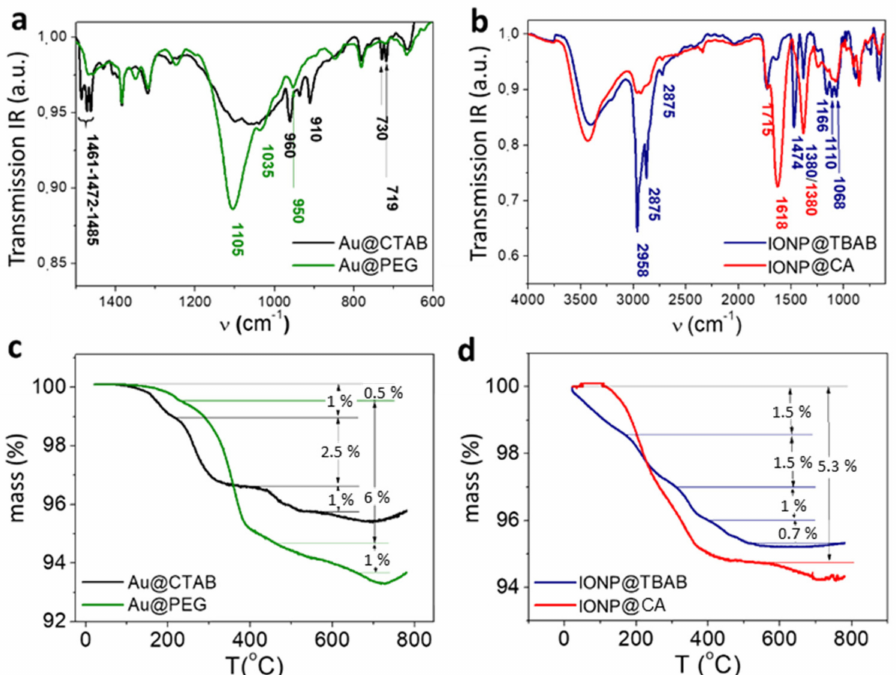
Figure 2. ( a ) FT-IR transmission spectra and ( c ) TGA curves of the AuNR coated with CTAB (Au@CTAB), and the AuNR after PEG functionalization (Au@PEG). ( b ) FT-IR transmission spectra and ( d ) TGA curves of IONP coated with TBAB (IONP@TBAB), and again after treatment with CA (IONP@CA). The complete spectrum of panel ( a ) can be found in Figure